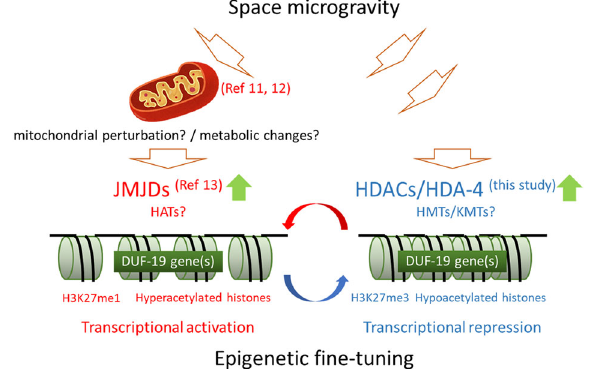
Fig. 6 Schematic illustration of epigenetic control by HDACs in space microgravity. The expression of certain genes, including negative regulators of growth and development such as the DUF-19 gene(s), is epigenetically fi ne-tuned to adapt to the space microgravity in C. elegans